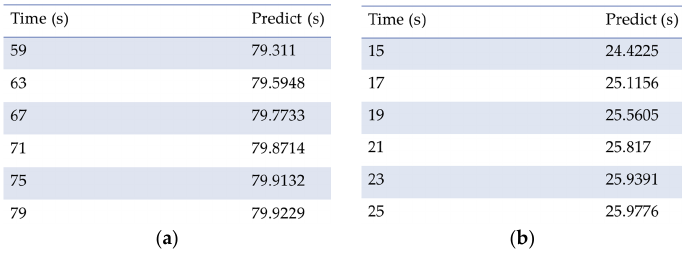
Figure 4. The prediction of time ‐ to ‐ trigger (TTT) of handover. ( a ) User equipments (UEs) velocity = 30 km/h and ( b ) UE velocity = 120 km/h.